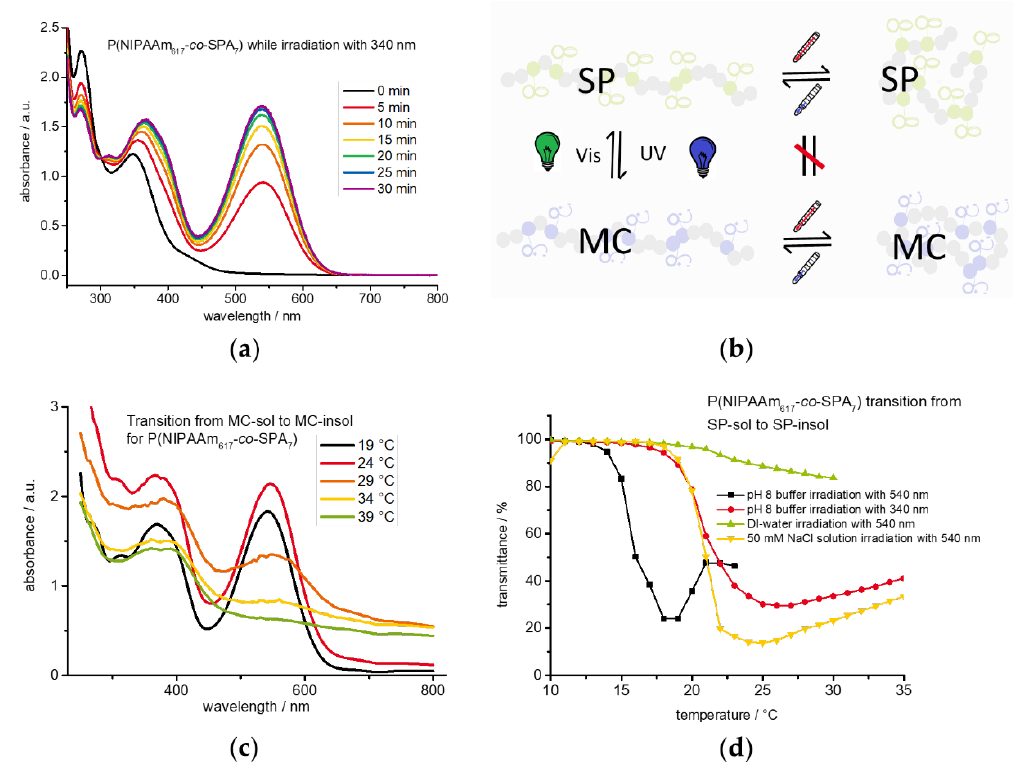
Figure 4. ( a ) UV – Vis spectra of P(NIPAAm 617 - co -SPA 7 ) in a pH 8 buffer while being irradiated at 340 nm at 15 °C; ( b ) Switching scheme depicting the four different states adopted by the copolymers; ( c ) UV – Vis spectra of P(NIPAAm 617 - co -SPA 7 ) in a pH 8 buffer while being irradiated at 340 nm at different temperatures; ( d ) Transmittance of P(NIPAAm 617 - co -SPA 7 ) at 700 nm with increasing temperatures in various aqueous solutions.